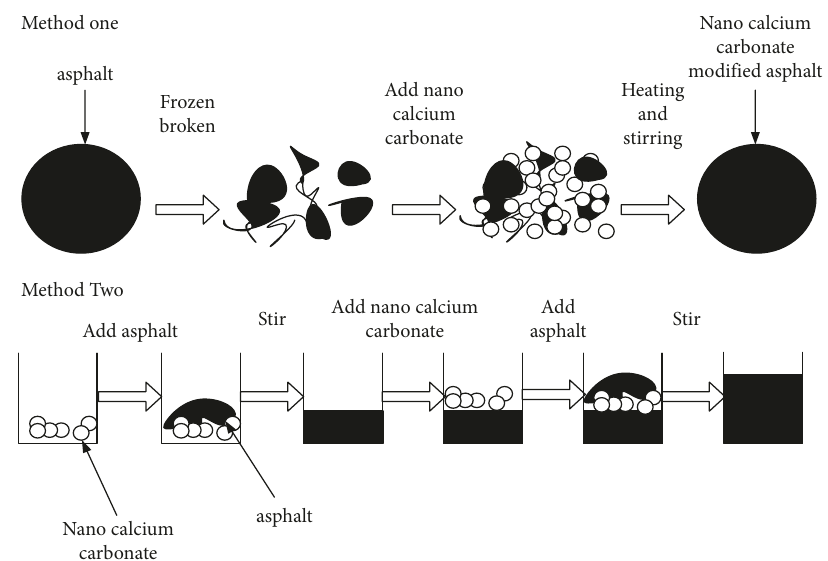
Figure 5: Preparation method of nano-calcium carbonate material-modified asphalt.